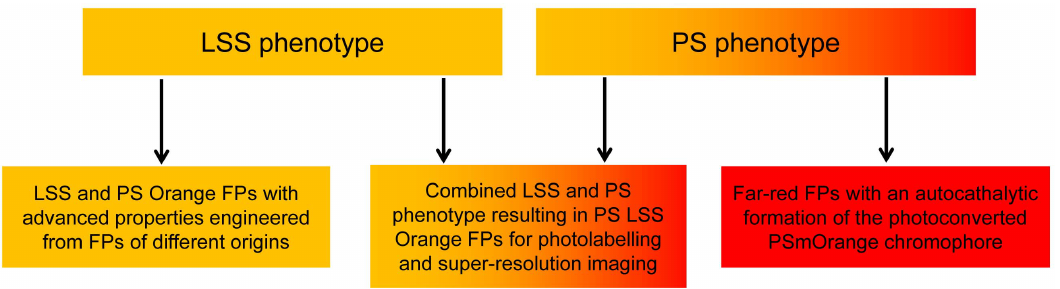
Figure 7. Possibilities for the future design of advanced orange and far-red fluorescent proteins.